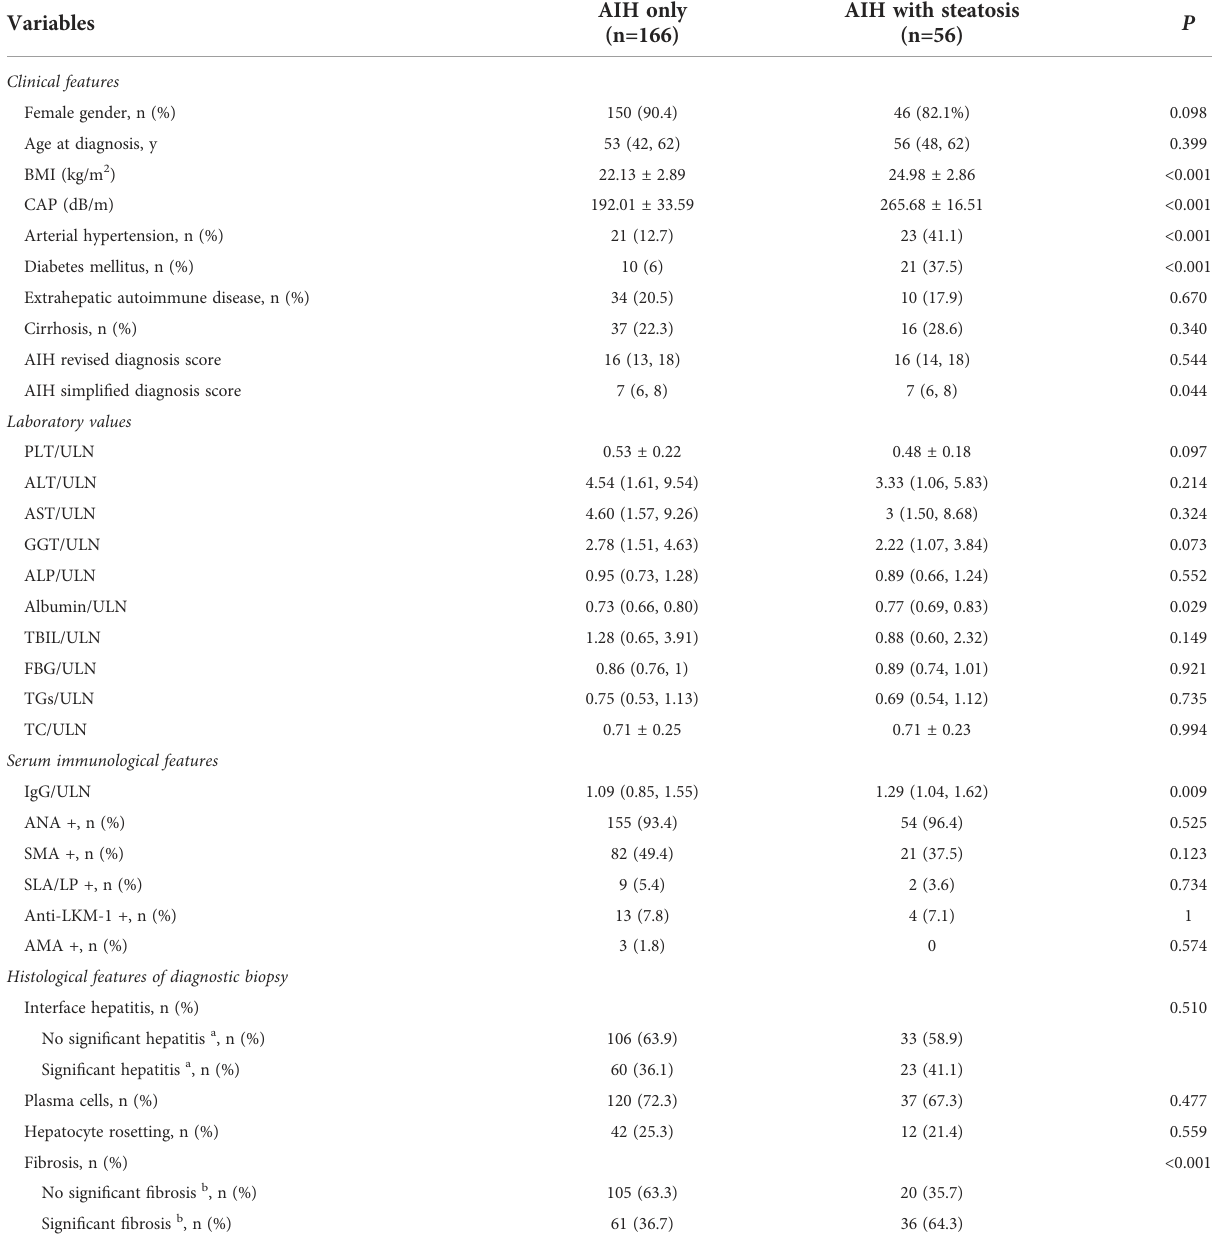
TABLE 2 Baseline clinical, biochemical, immunological and histological features of AIH patients based on hepatic steatosis status. Variables